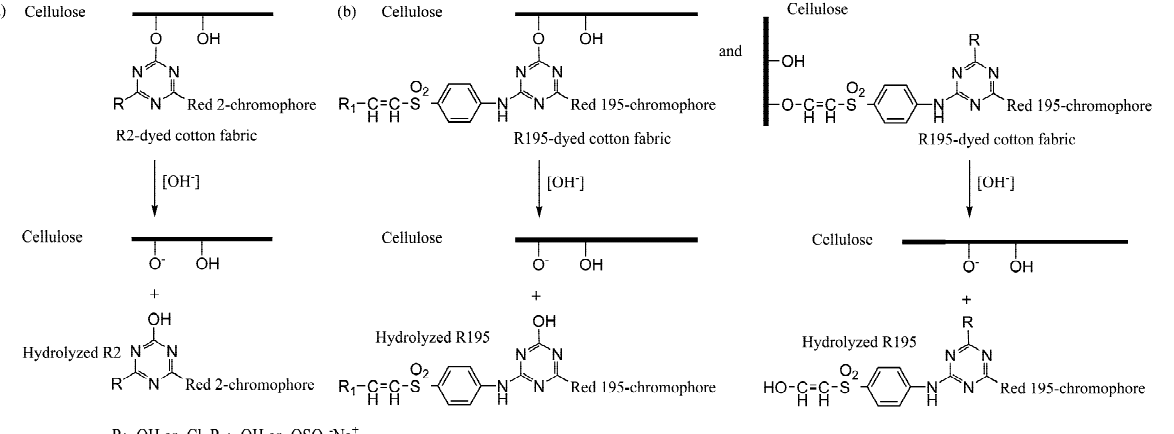
Figure 6. Hydrolysis of the ether bonds between the cellulose and reactive dyes of ( a ) R2 and ( b ) R195.